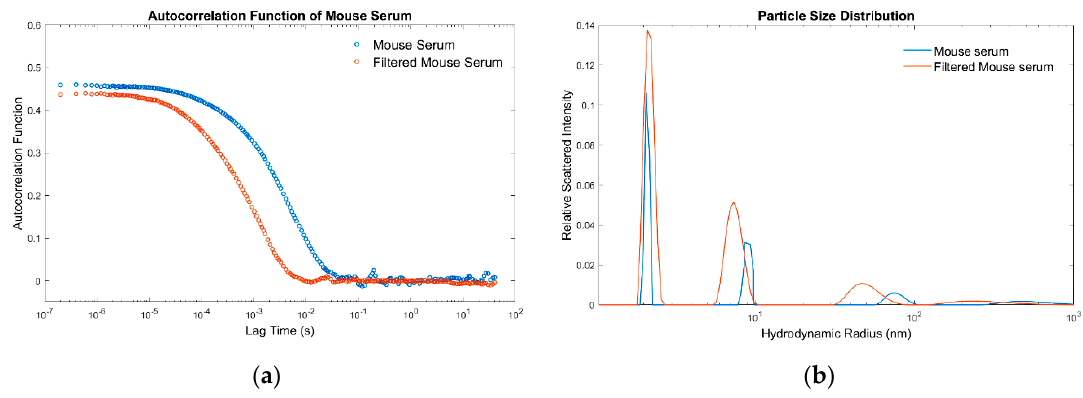
Figure 2. DLS data of mouse serum before and after filtering through a 1.2 µ m micropore membrane: ( a ) Correlation functions; ( b ) Example of relative scattered intensity as a function of hydrodynamic radius based on CONTIN